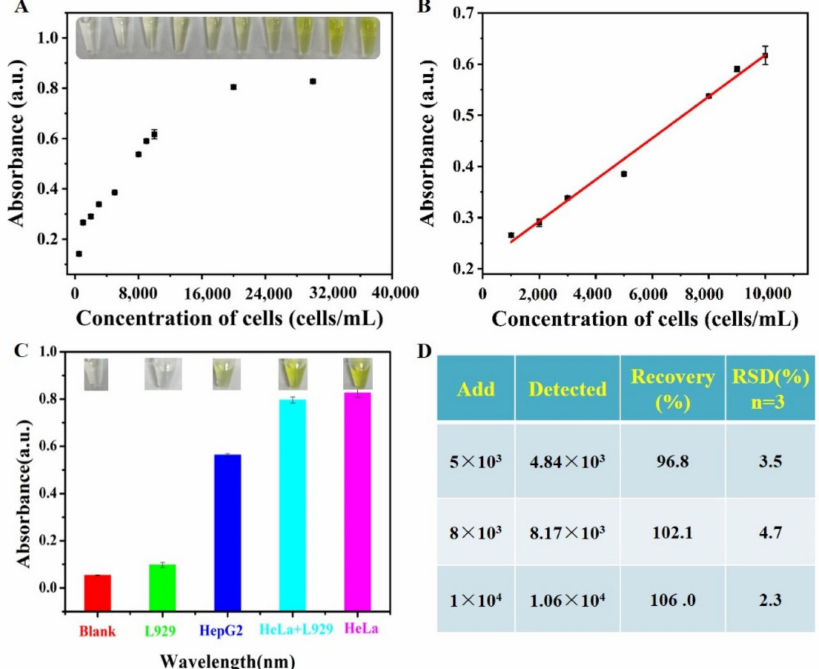
Figure 5. ( A ) The absorbance intensity response of TMB-H 2 O 2 system at 450 nm toward various concentrations of HeLa cells (5 × 10 2 , 1 × 10 3 , 2 × 10 3 , 3 × 10 3 , 5 × 10 3 , 8 × 10 3 , 9 × 10 3 , 1 × 10 4 , 2 × 10 4 , 3 × 10 4 cells/mL). The insets show the images of their corresponding solution. ( B ) Linear relationship of the absorbance intensity versus HeLa cell concentration from 10 3 to 10 4 cells/mL. ( C ) Specificity of the colorimetric sandwich-type aptasensor toward different interference cells. The insets show the images of their corresponding solution. ( D ) The recovery